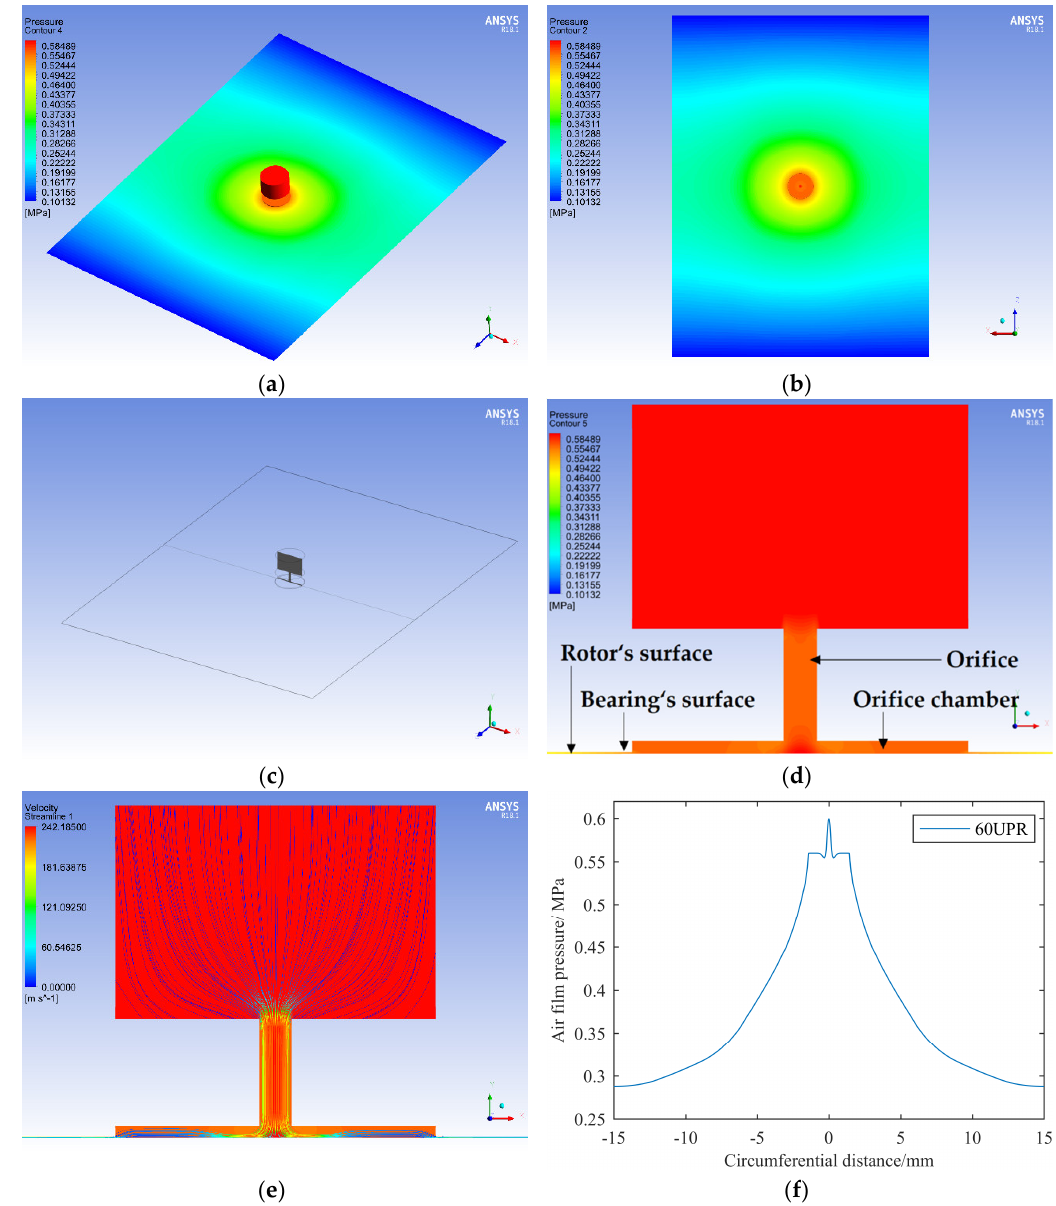
Figure 7. Analysis of the film’s flow field with an error frequency of 60 undulations per revolution (UPR): ( a ) film pressure distribution of the whole flow field; ( b ) film pressure distribution on rotor surface; ( c ) schematic diagram of radial section at orifice; ( d ) pressure distribution on radial section; ( e ) streamline distribution on radial section; ( f ) pressure distribution curve on the rotor surface along the circumferential direction.